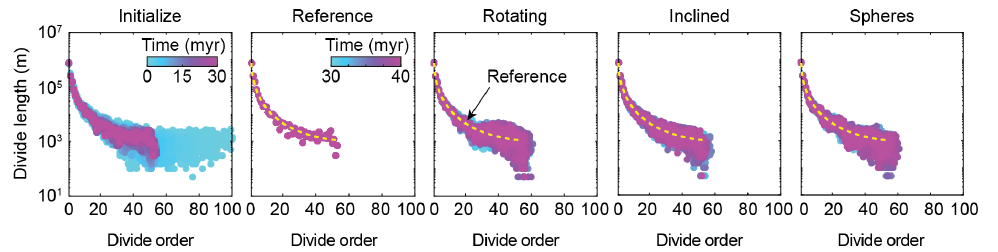
Figure 7. Changes in divide length for divides of different orders during the landscape evolution experiments. Divides have been ordered with the Topo ordering